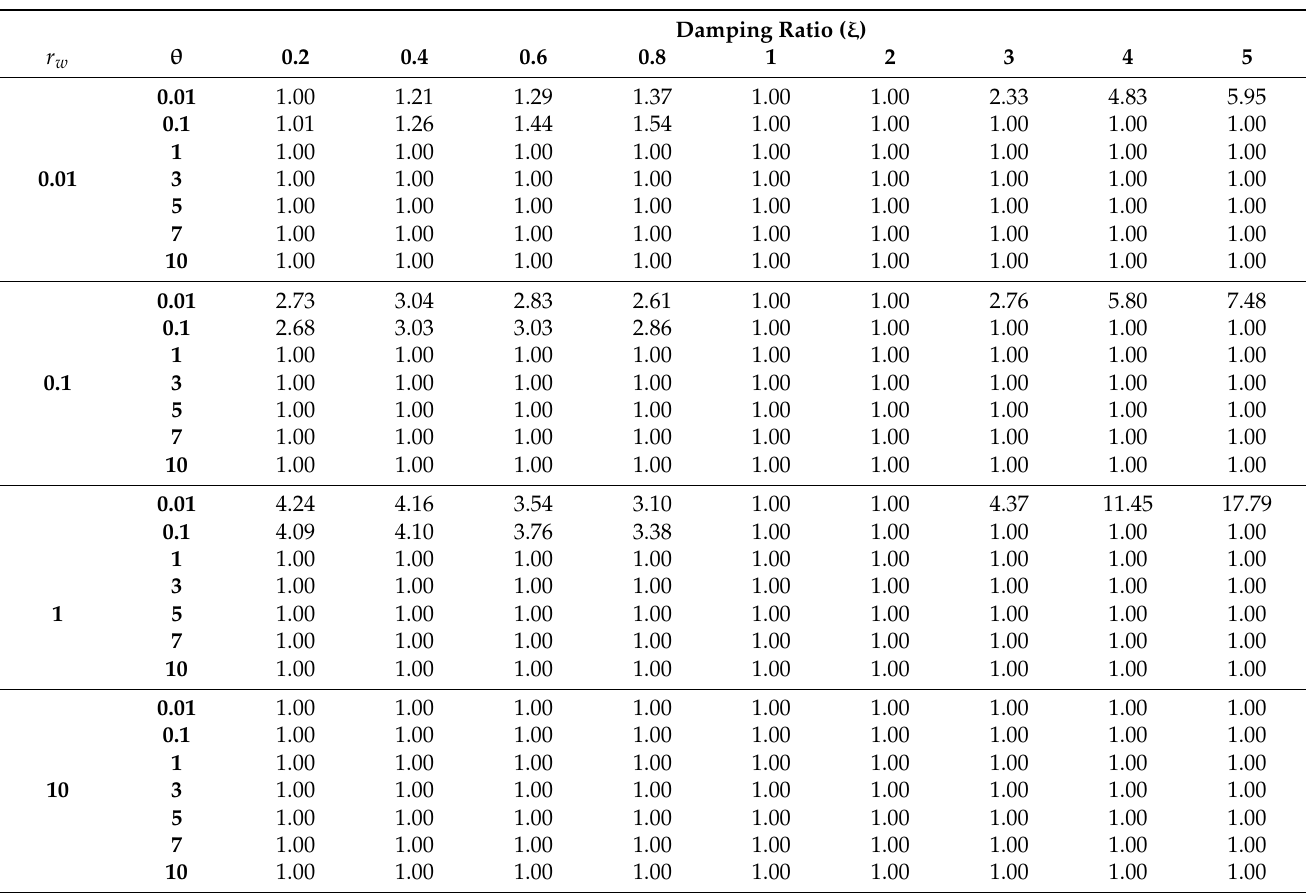
Table 14. Normalized IAE for MPC (Process 4, Disturbance